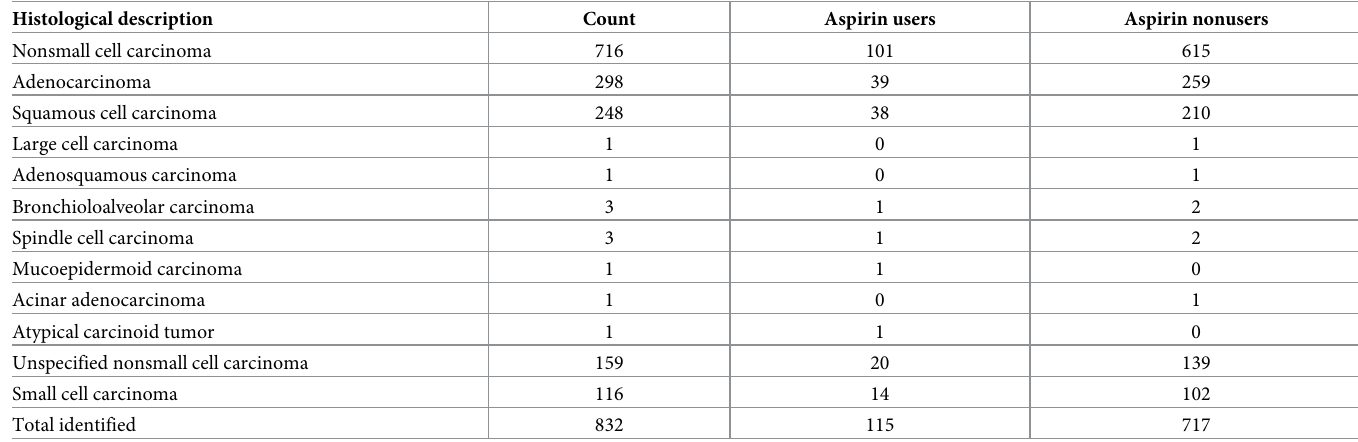
Table 3. Details regarding histological types of lung carcinoma in 832